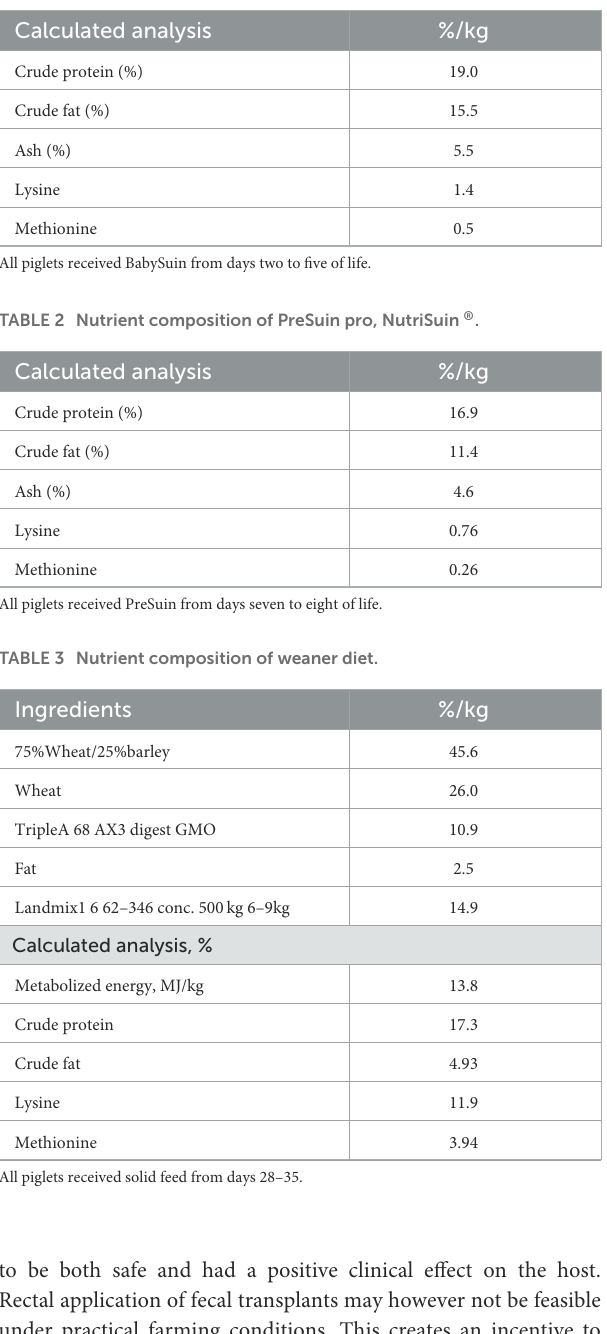
TABLE 1 Nutrient composition of BabySuin, NutriSuin ® .